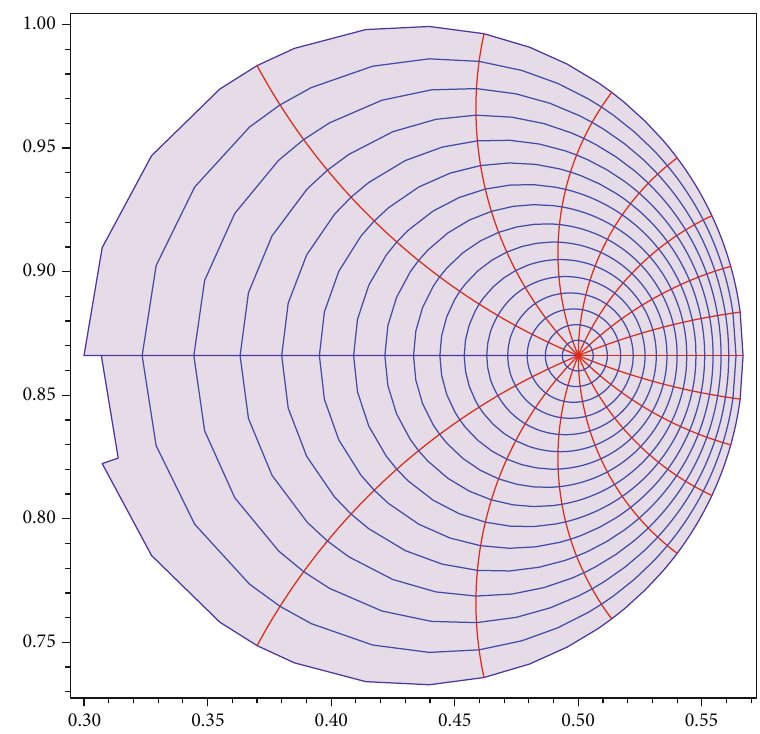
Figure 1: The image of the unit disc under the mapping of Δ τ